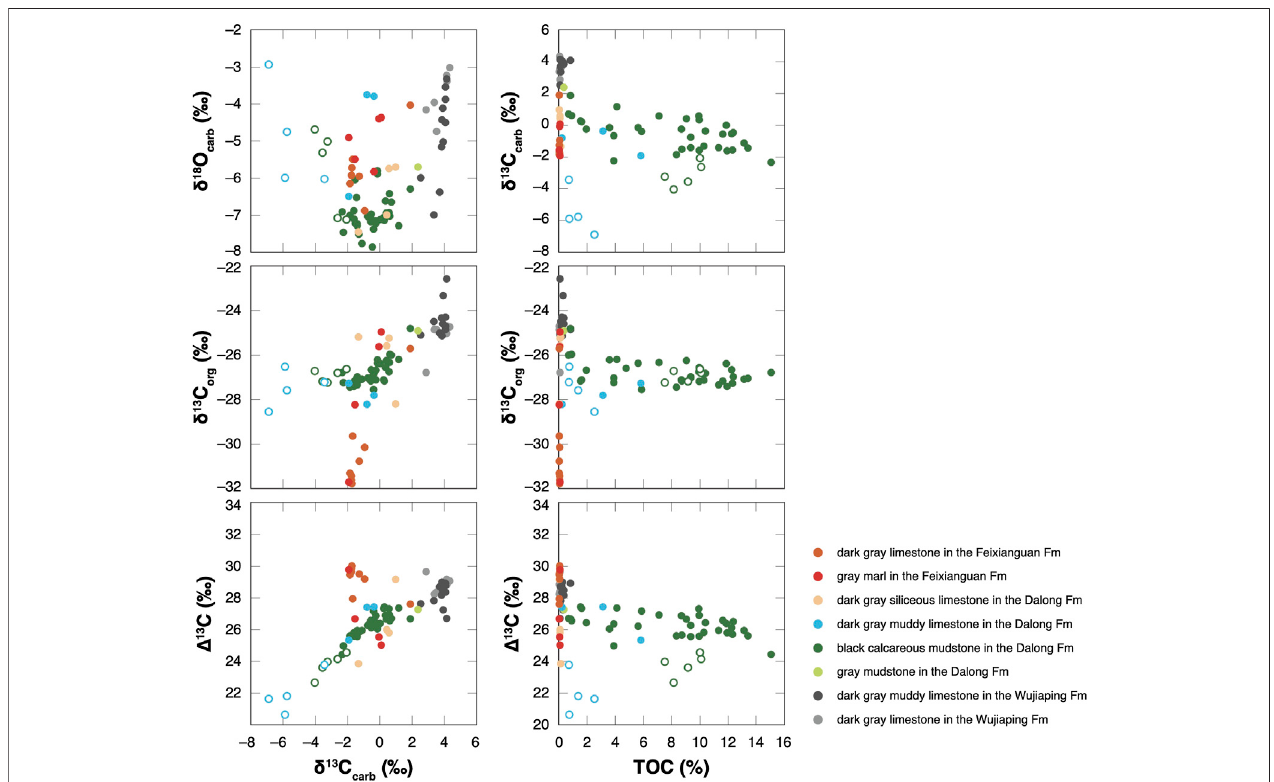
FIGURE 5 | Geochemical cross-plots of the analyzed P-TB interval at Chaotian.